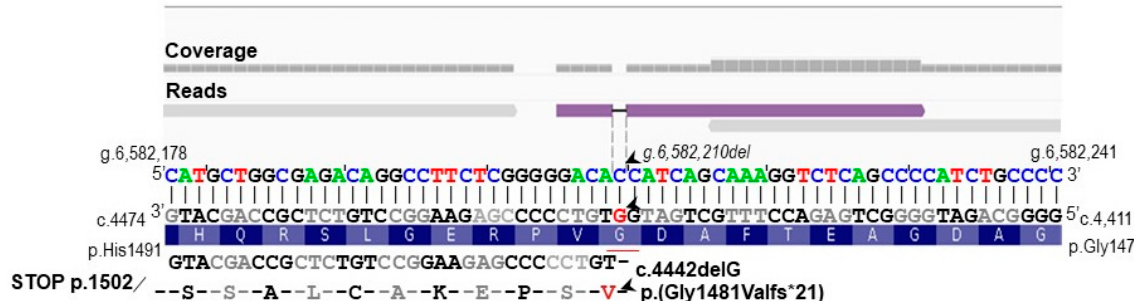
Figure 3. Alignment of liGS reads using the IGV tool, showing the frameshift deletion at NC_000002.12:g.6,582,210 in exon 30 of CHD4 . The alignment of GS reads to the reference genome and the corresponding amino acids are indicated. The CHD4 cDNA is in antisense orientation. The deleted G nucleotide is underlined in red. Below, the position of the c.4442delG relative to the cDNA (RefSeq NM_001273.5) and amino acid sequences is indicated. Arrowheads indicate the position of the frameshift deletion relative to the reference genome sequence, to the reference cDNA, and to the variant amino acid. Due to low sequence coverage, this is only of confirmatory value for the ES data.